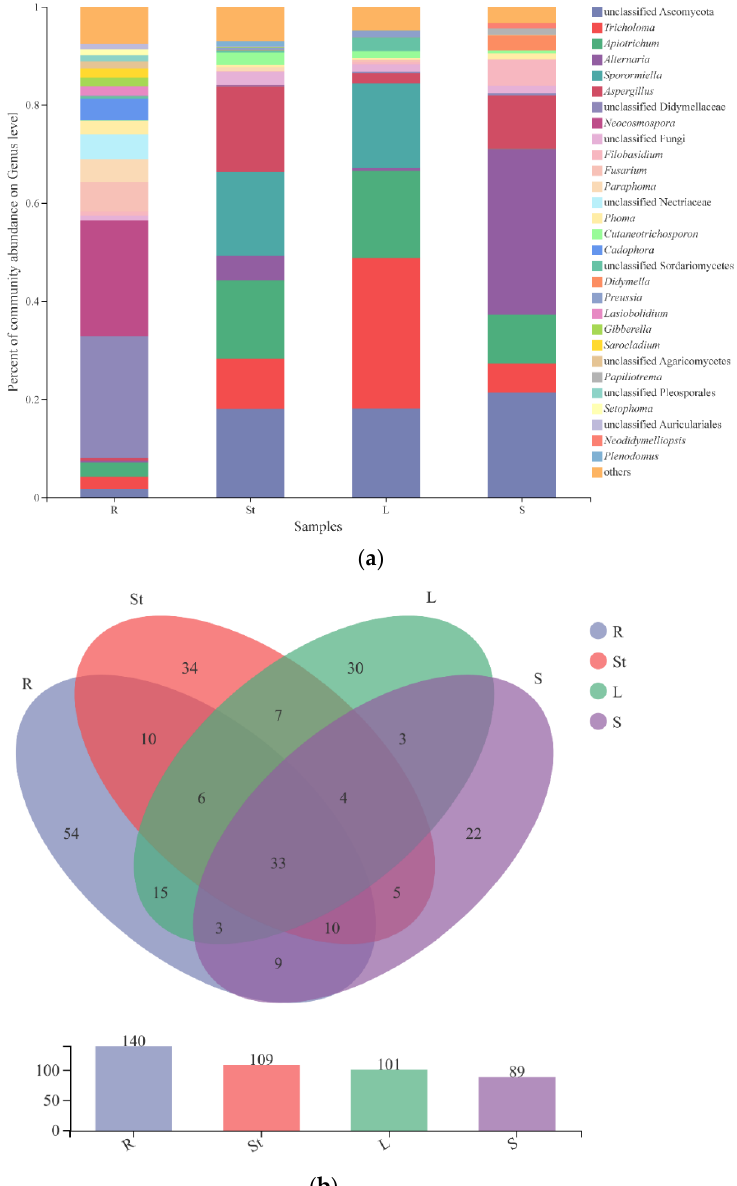
Figure 3. Fungal composition and relative abundance of S. alopecuroides : ( a ) different organs ’ com- munity composition of S. alopecuroides at genus level; ( b ) Venn diagram showing shared and unique fungal genera in each organ (root, stem, leaf, and seed). Table 4. Common and unique genera of endophytic fungal fungi from different organs of S. alopecu- roides.